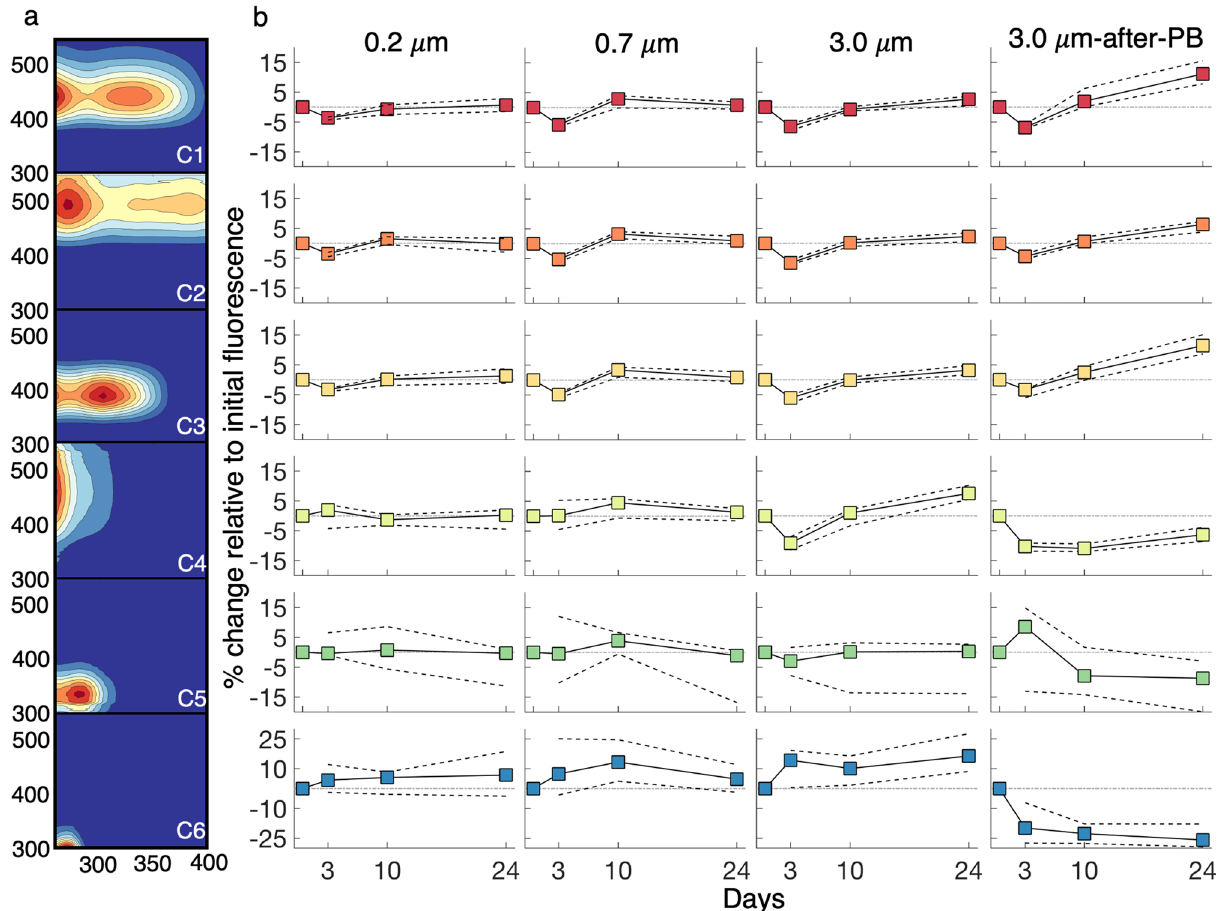
Figure 4. ( a ) Component fingerprints for the six component PARAFAC model, corresponding to component change in treatments in the right panel. ( b ) Median (solid line with colored squares) and interquartile range (dashed lines) for percent change in individual PARAFAC components (relative to initial component loading) for 0.2 μm, 0.7 μm, 3.0 μm and 3.0 μm-after-PB treatments. Percent change is relative to the initial fluorescence maximum for each component, indicating change in that component irrespective of change in other